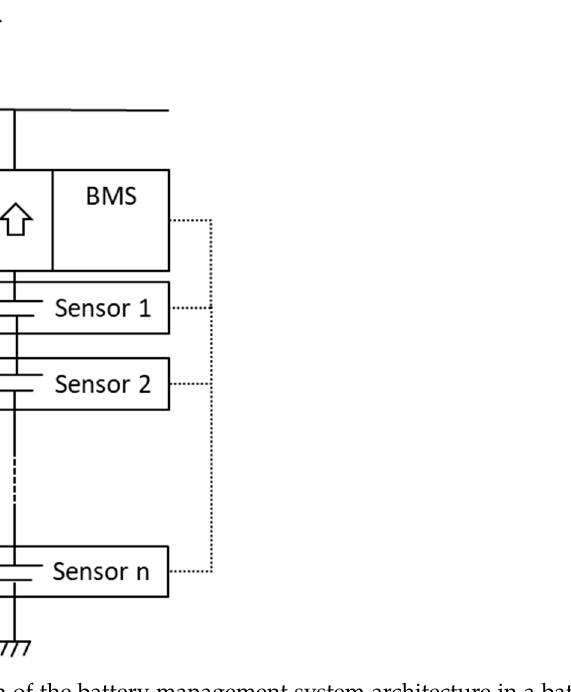
Figure 1. Block diagram of the battery management system architecture in a battery string setup with a 12 V block.